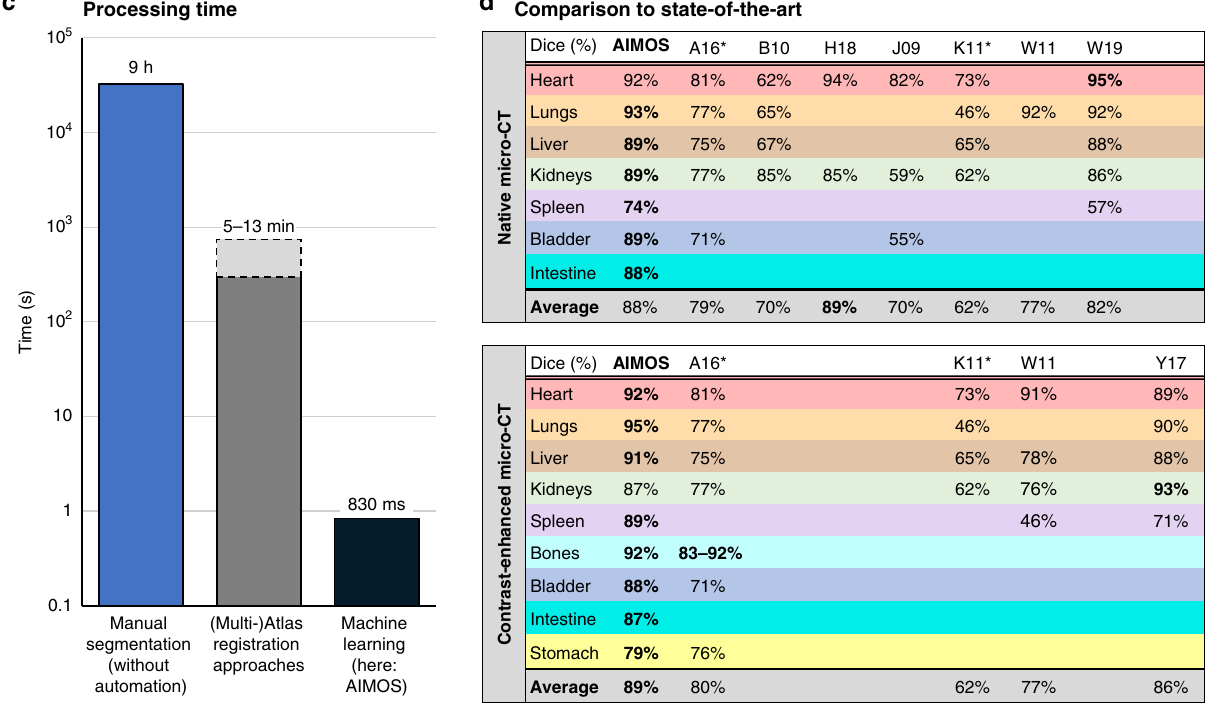
Fig. 2 Quantitative results of segmentation performance. a , b Box plots of Dice scores per organ; each box extends from lower to upper quartile values of data, with a black line at the median; the whiskers extend to the outmost data point within 1.5× the interquartile range; the outliers beyond the whiskers are shown as diamonds; the blue lines represent human segmentation performance. $ The human annotators segmented bones with a semi-automatic thresholding function, which may overestimate human consistency as compared to purely manual segmentation. a Each box plot represents n = 140 independent scans from 20 biologically independent animals. b Each box plot represents n = 81 independent scans from eight biologically independent animals. c Processing time (in log scale) to segment one 3D whole-body scan of a mouse if done manually, with current state-of-the-art methods (atlas registration 36,37 ) or with machine learning approaches (here: AIMOS). d Median dice scores of AIMOS compared with those of the state-of-the-art from literature for native and contrast-enhanced microCT (scores are not based on the same dataset). Studies marked with asterisks exploited multimodal inputs of native microCT and MRI; as MRI provides high contrasts for soft abdominal organs, these studies are listed for both tables. Source data are provided as a Source Data fi Dice scores for most other organs, which are between 87% and than for the human segmentation (69%). The low segmentation 95% for the kidneys and the lungs, respectively. For the contrast- enhanced microCT dataset, we also segmented the stomach, another low-contrast organ in CT, for which AIMOS reached a score of 79%, which is lower than for the other organs but higher